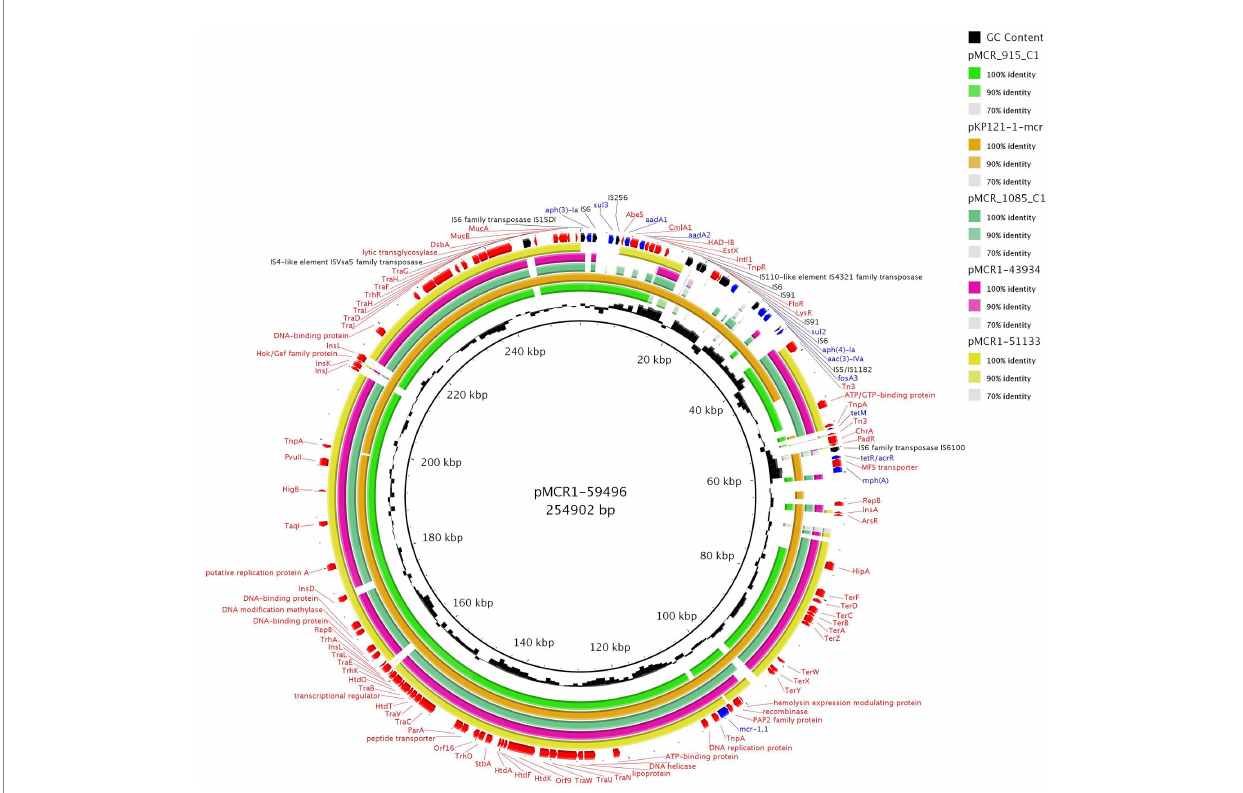
FIGURE 4 BRIG comparison of mcr-1.1 -encoding IncHI2/ST4 plasmids. The plasmid pMCR1-59496 from K. pneumoniae ST726 identified in our study from urine sample (OP950836) was used as a reference. Two other plasmids originated from our collection, including pMCR1-43934 from E. coli ST8186 from tonsil swab sample and pMCR1-51133 from E. coli ST117 from a urine sample. The sequence alignment includes pMCR_915_C1 (MT929284.1) and pMCR_1085_C1 (MT929286.1) from E. coli recovered from raw turkey meat imported to the Czech Republic from Poland and one of plasmid